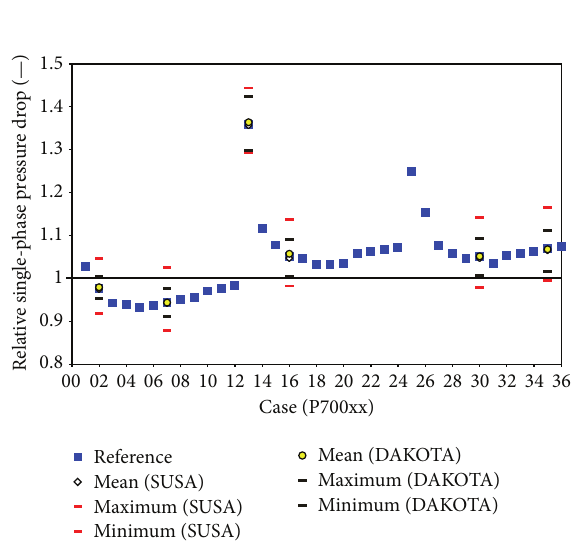
Figure 3: Relative single-phase flow pressure drop and uncertainty band for TRACE-SUSA and